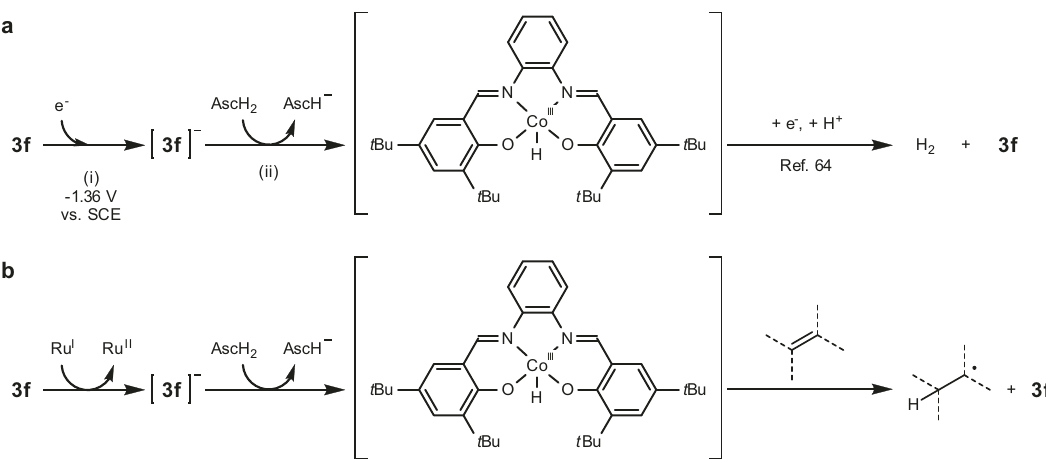
Fig. 4 Evaluation of the proposed mechanism by electrochemical analysis. a Interpretation of the observations in cyclic voltammetry. b Plausible mechanisms of the cobalt-photoredox catalyzed hydrogenation in analogy with the electrochemical reaction; SCE saturated calomel electrode, AscH 2 ascorbic